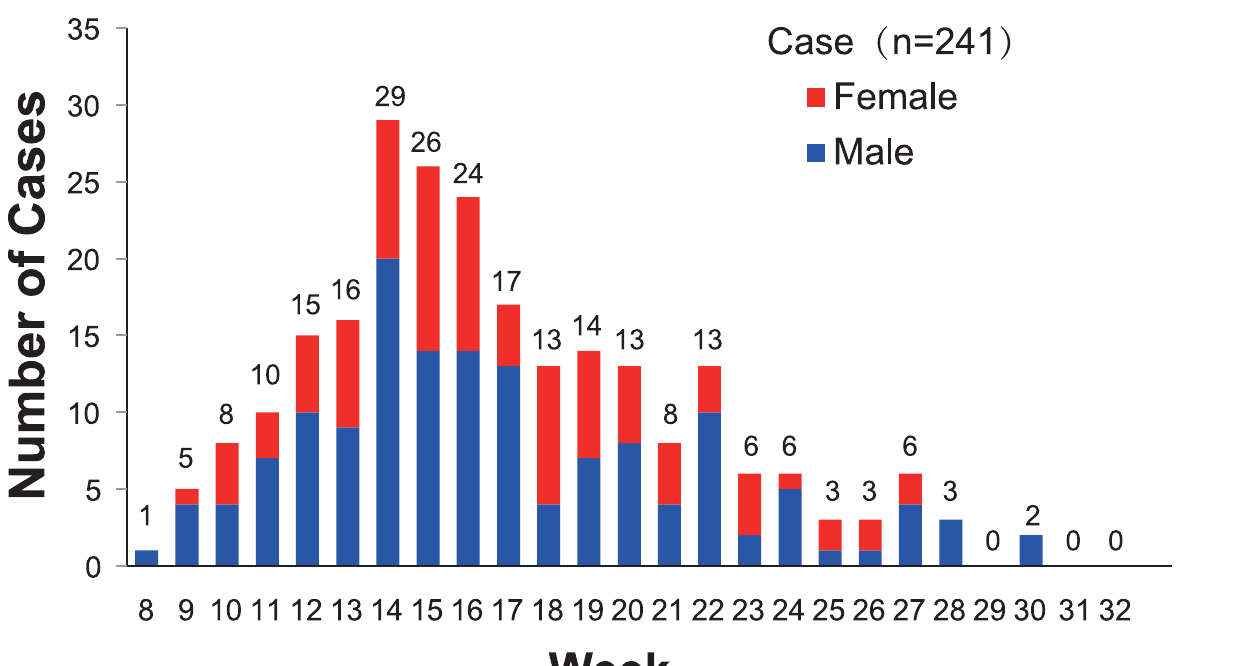
Fig 1. Reported rubella cases by week of onset in Anqing city of Anhui province in 2012.